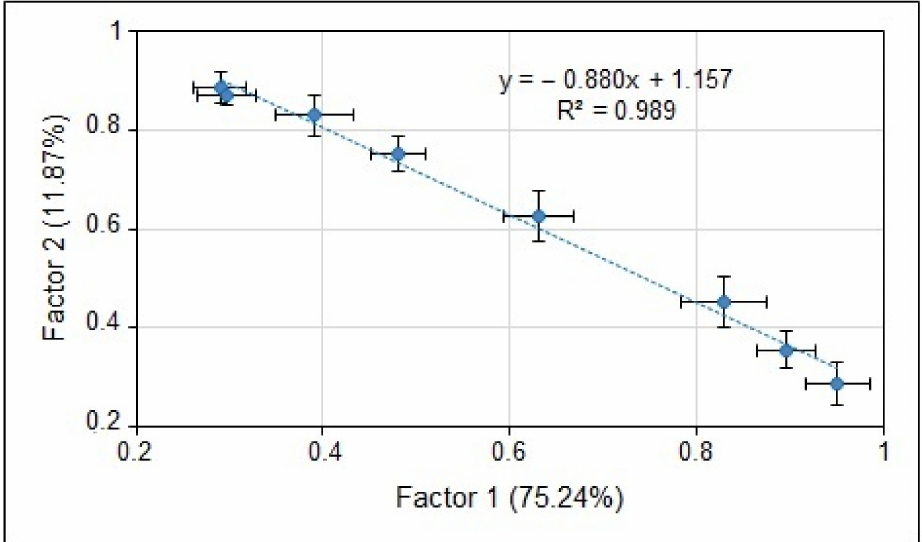
Figure 6. The Mg LIBS spectra in the FA